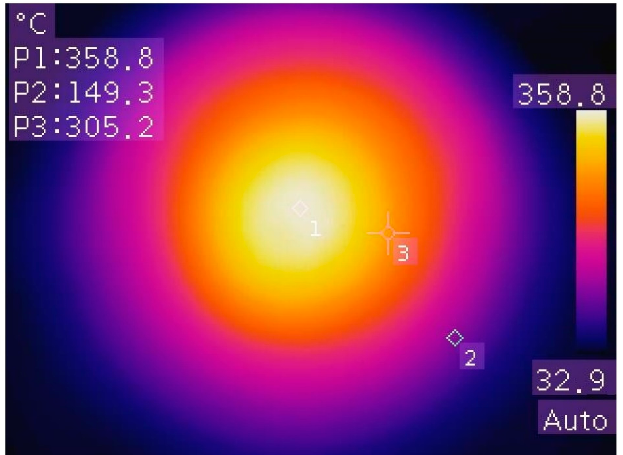
Figure 7. Temperature distribution on the heat receiver surface of CSR.